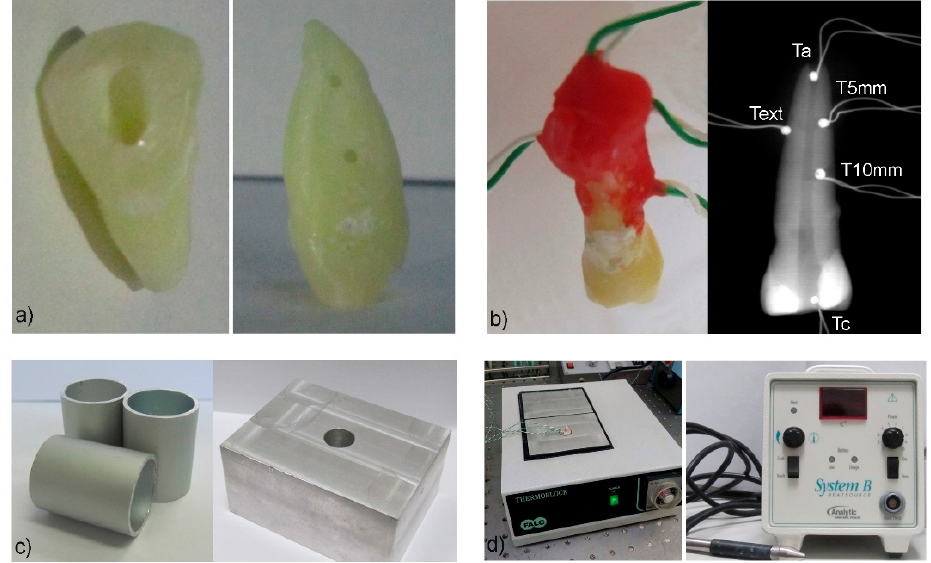
Figure 1. Specimen preparation and setup. Instrumented root canal and holes drilled through the root ( a ); thermocouple placement ( b ); aluminum tubes and block ( c ); and thermostatic and heating systems ( d ).